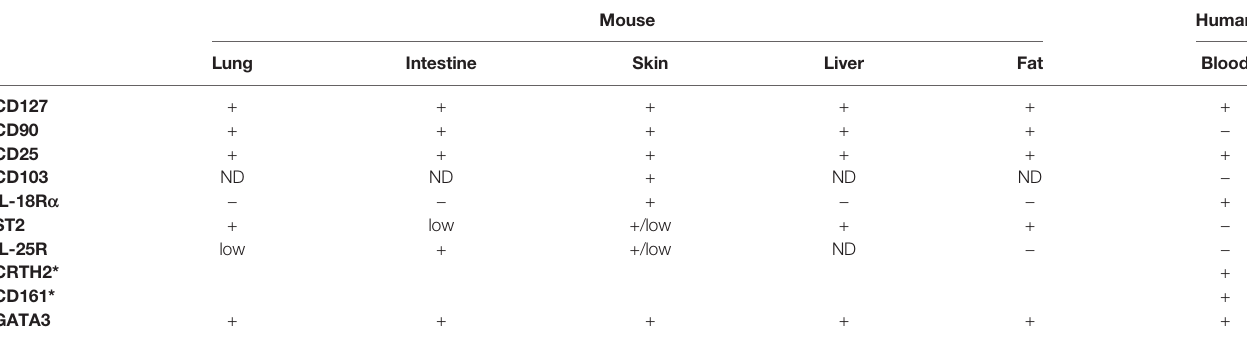
TABLE 1 | Summary of ILC2